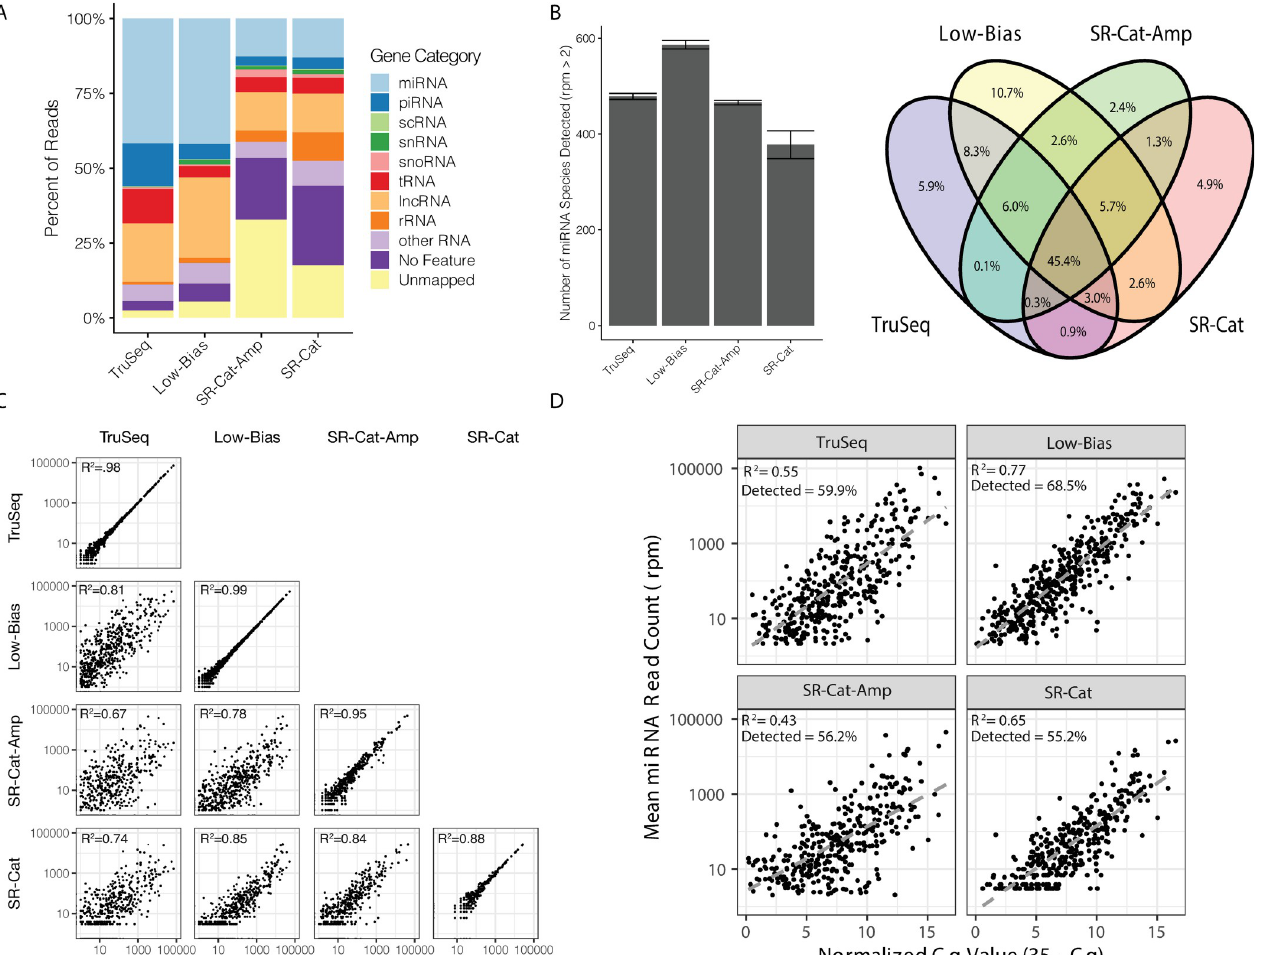
Fig 5. Sequencing human brain small RNA with SR-Cat-Seq workflow. (A) Comparison of the relative abundance of the different ncRNA categories with four different small RNA sequencing workflows (TruSeq, Low-Bias, SR-Cat-Amp and SR-Cat). (B) Left: Comparison of the number of unique miRNA species detected by four workflows. Right: Venn diagram showing overlap of miRNA species detected among the four workflows. C) Correlations of read counts of miRNA in human brain RNA among the four workflows. The diagonal shows the correlation of two technical replicates of each method. R 2 values are plotted in the upper-left corner of each plot. D) Correlation of miRNA read counts from each workflow compared to qPCR cycle threshold values from human brain RNA. R 2 values and the percentage of miRNAs detected with rpm > 2 by each sequencing method are plotted in the upper-left corner of each plot.